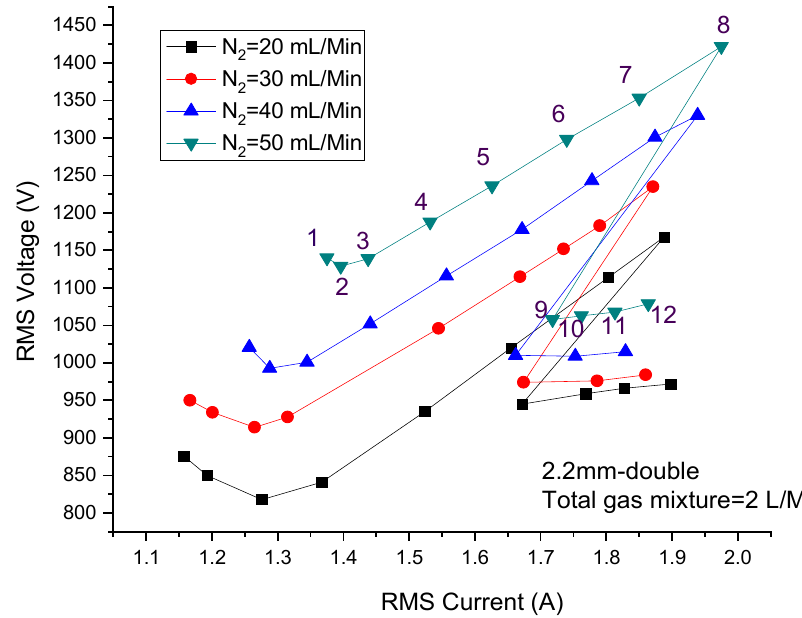
Figure 2. Current voltage curve of discharge using argon-doped nitrogen.